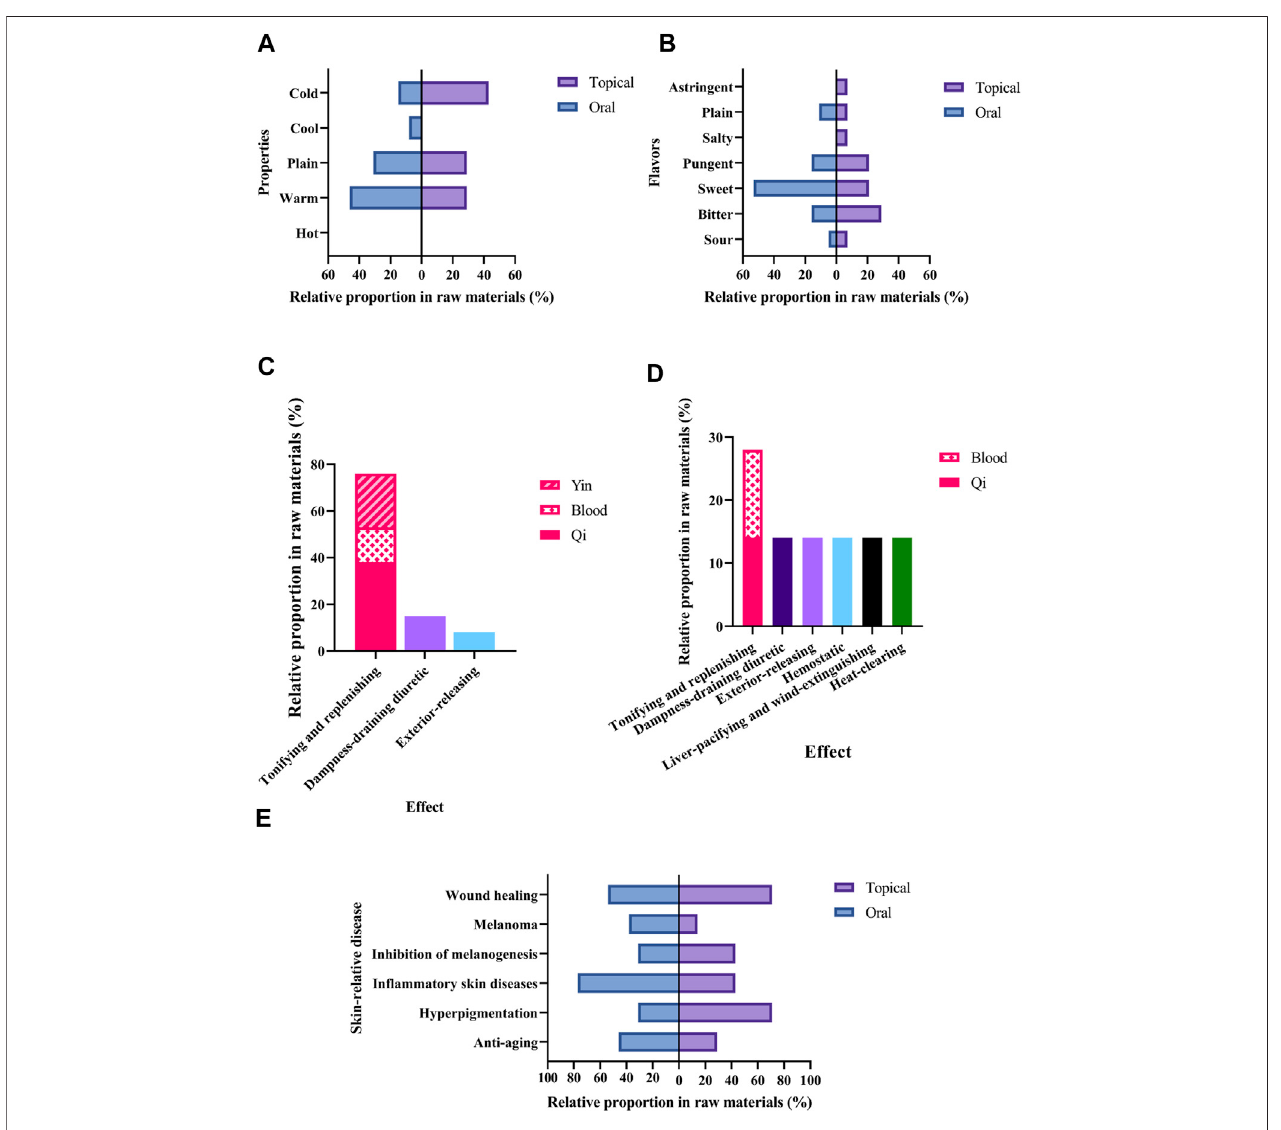
FIGURE5| CharacteristicsofmedicinalmaterialswithanRFC > 0.2inskinwhiteningprescriptions. (A) Propertiesand (B) Flavors.Histogram oftraditionalef fi cacy classi fi cations. (C) oral prescriptions and (D) external prescriptions. (E) Modern research related to skin.